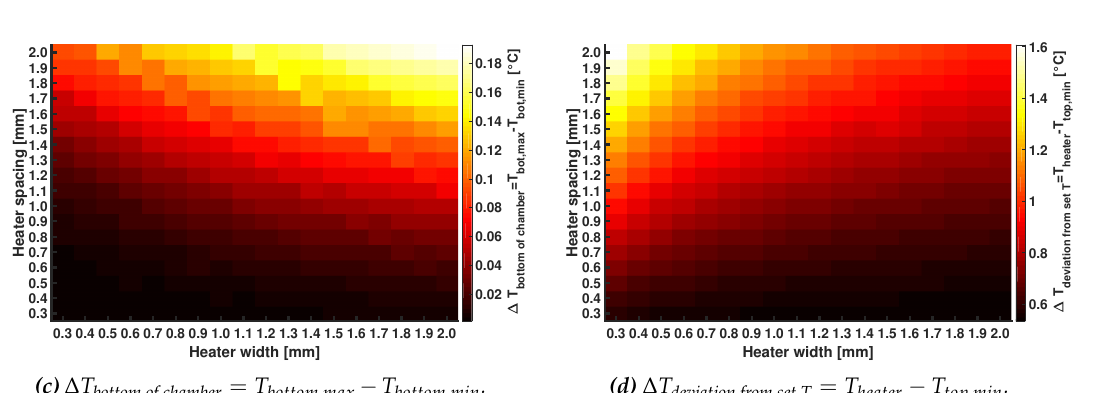
(c) ∆ T bottom of chamber = T bottom , max − T bottom , min . (d) ∆ T deviation from set T = T heater − T top , min .